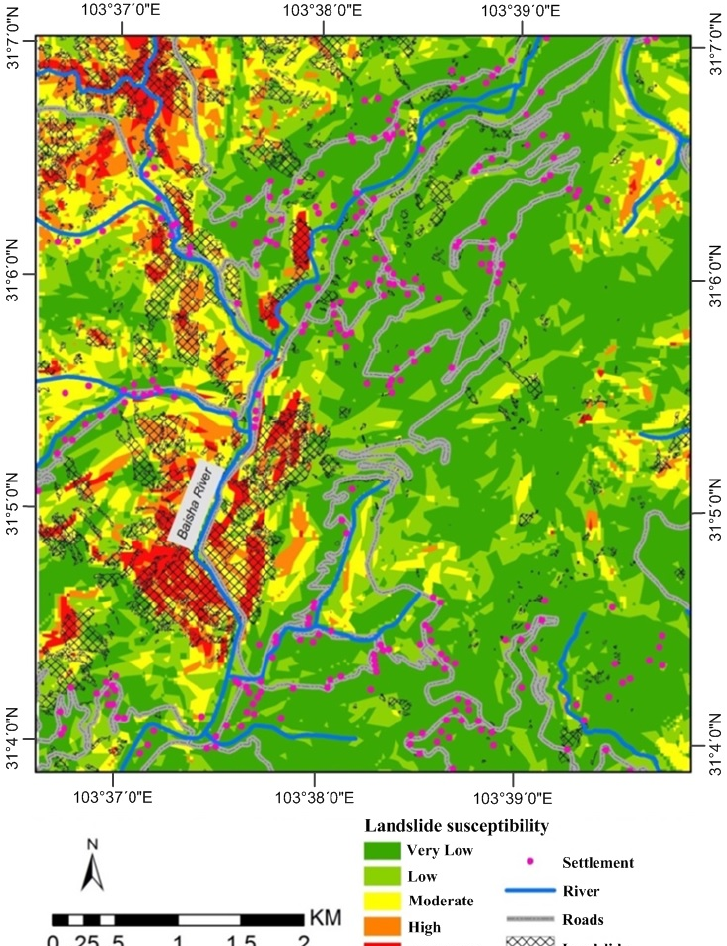
Figure 7. Landslide susceptibility map derived from Artificial Neural Network (ANN) (Levenberg-Marquardt